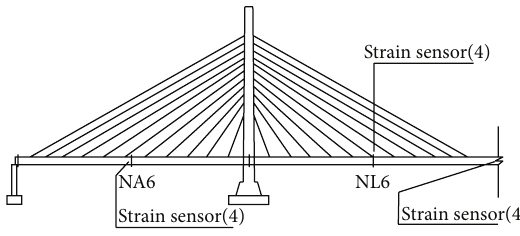
Figure 9: Welding crack monitoring points on the box